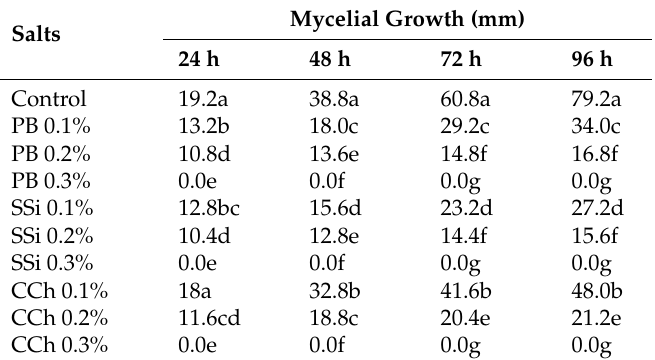
Mycelial Growth (mm)